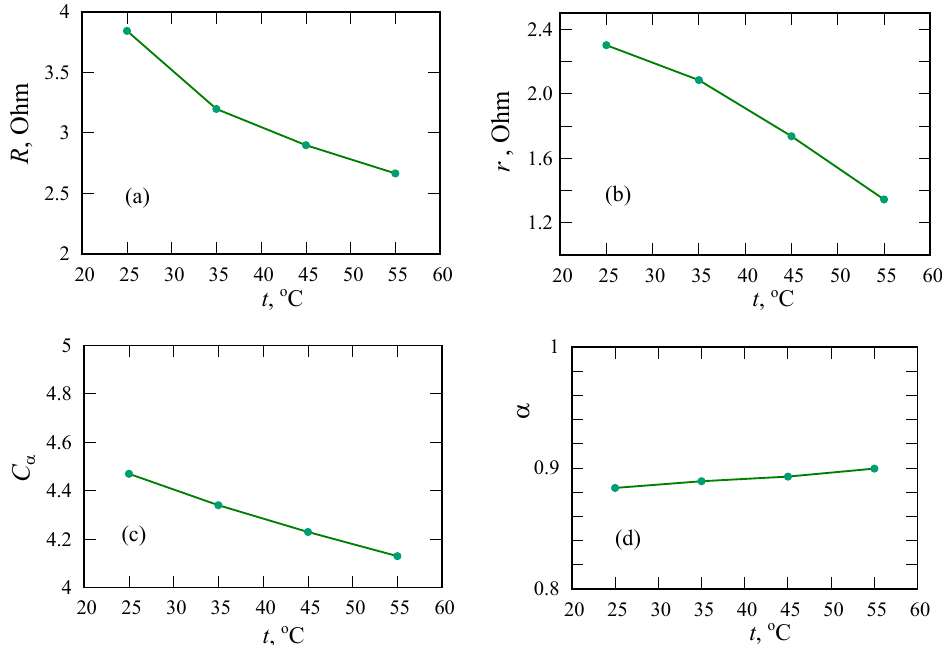
Figure 9. Equivalent circuit model parameters for different temperatures. Resistances R ( a ) and r ( b ), CPE parameter C α or fractional capacity in 10 − 5 s α · Ohm − 1 ( c ) and fractional order α ( d